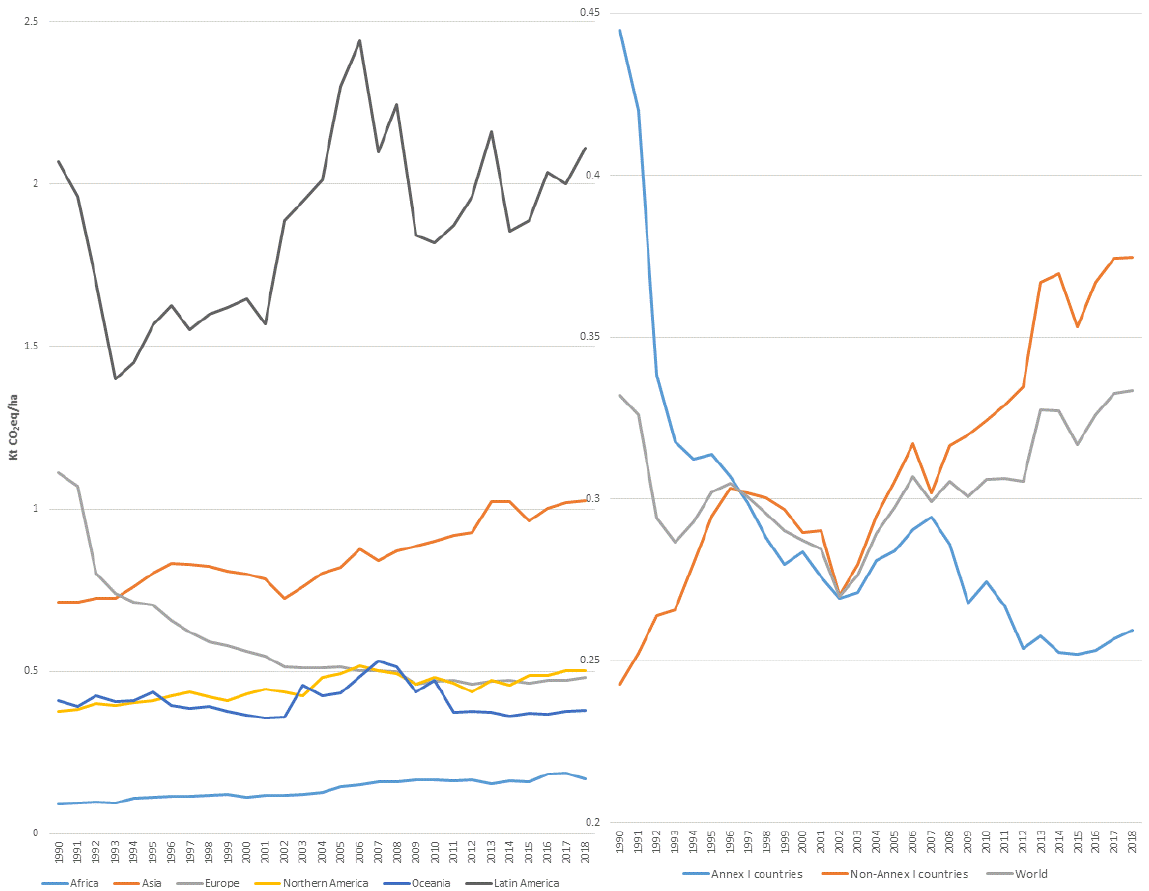
Figure 6. GHG emission from energy use in agriculture per unit of cropland by continent (left) and by Annex I and non-Annex I countries (right) for 1990–2018 (KtCO 2 eqha − 1 ). Source: FAOSTAT, based on data from IEA and UNSD